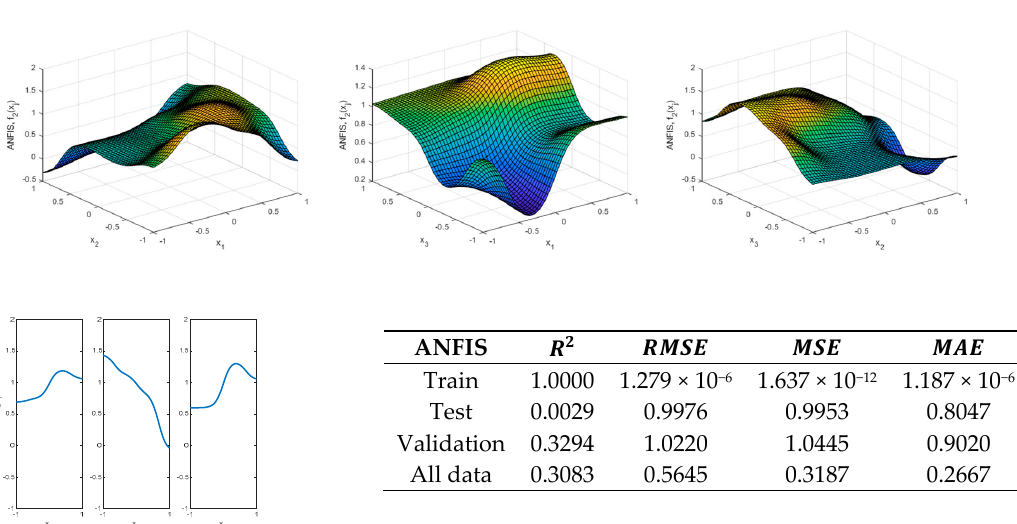
Figure 25. Response surface obtained with the zero-order Sugeno FIS employed for modeling f 2 using four Gaussian membership functions for the inputs along with an ANFIS (2 epochs, 64 fuzzy rules).